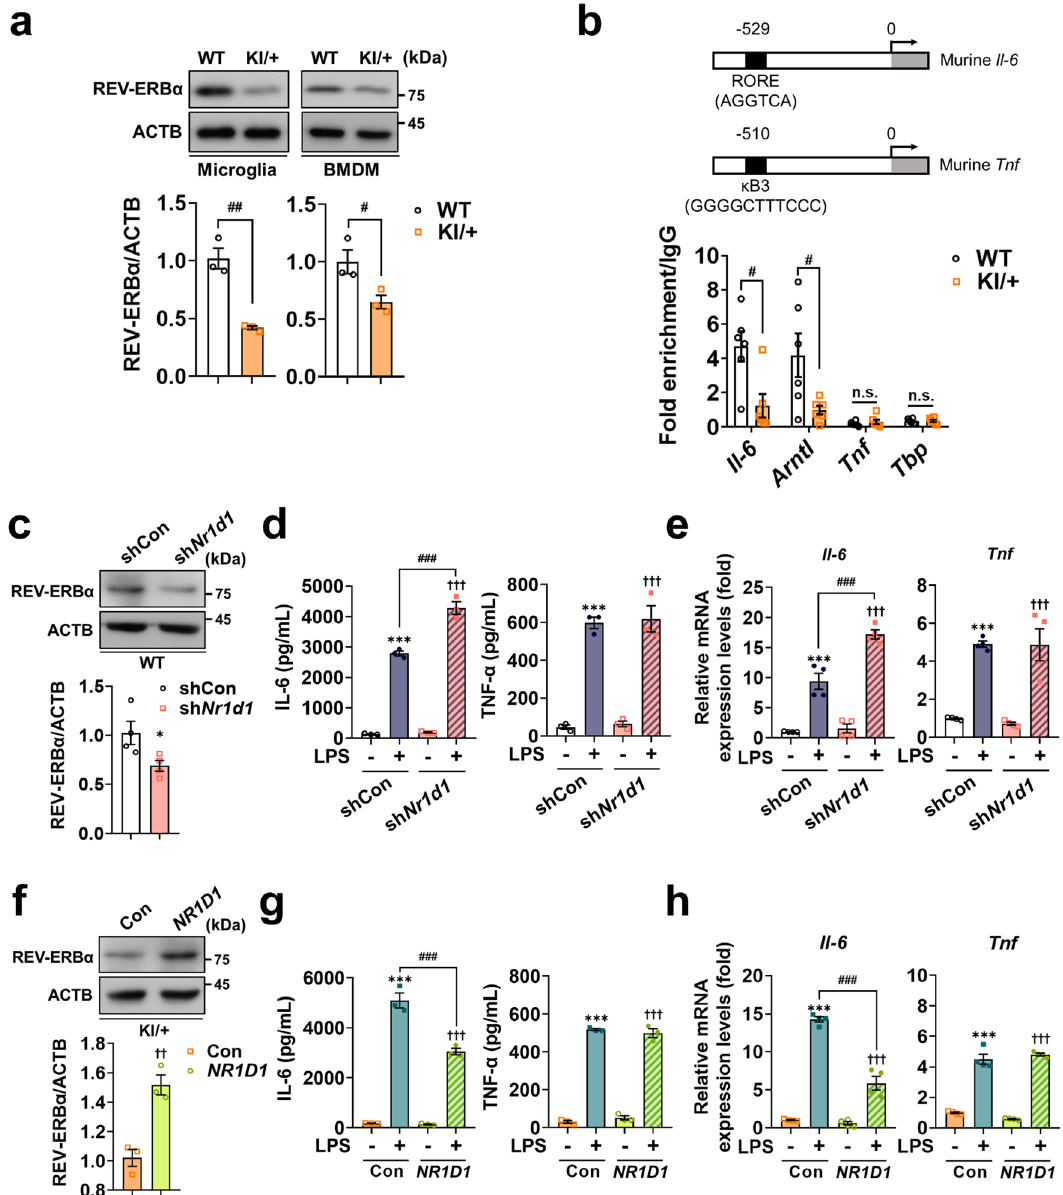
Fig. 6 Psen2 N141I mutation selectively elevates production of clock-controlled cytokines through the downregulation of REV-ERB α in innate immune cells. a Analyses of REV-ERB α protein levels by western blotting in microglia ( n = 3) ( ## p = 0.0028) and BMDM ( n = 3) ( # p = 0.042). b Primer target regions. Average fold enrichment of immunoprecipitated DNA fragments in microglia was analyzed by qRT-PCR in ChIP assay. Average fold enrichment was normalized to IgG of each gene ( n = 6) (WT vs KI/ + : # p = 0.0106 and # p = 0.0338; n.s., not signi fi cant; unpaired t -test). c Relative REV-ERB α expression levels in microglia transduced with lentivirus expressing shCon or sh Nr1d1 ( n = 4) (* p = 0.0423; unpaired t -test). d , e Secretion ( d ; n = 3) and mRNA levels ( e ; n = 4) of IL-6 and TNF- α in WT microglia transduced with sh Nr1d1 after LPS (1 μ g/mL) treatment for 12 h (untreated WT vs LPS-treated WT: *** p < 0.0001, *** p < 0.0001, *** p < 0.0001, and *** p = 0.0002; untreated KI/ + vs LPS-treated KI/ + : ††† p < 0.0001; LPS-treated WT vs